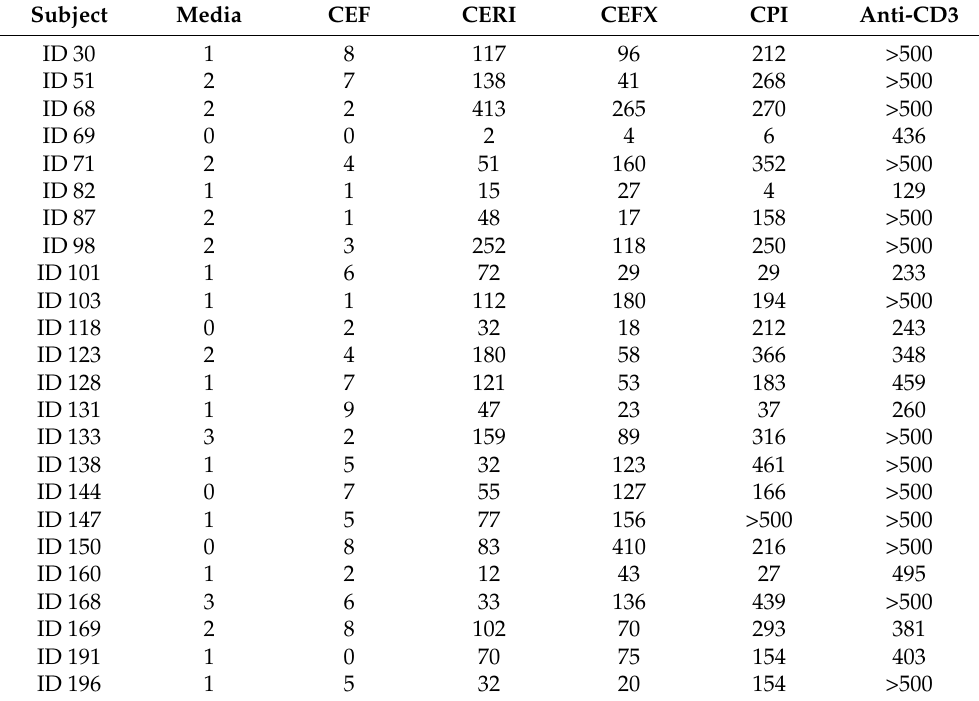
Table 1. CEF-negative PBMC can respond to other T cell stimuli. PBMC that showed no response to CEF (<10 SFU/300,000 PBMC) were tested simultaneously for CERI, CEFX, CPI and anti-CD3- induced T cell activation in a standard 24 h IFN- γ ImmunoSpot ® assay at 300,000 PBMC/well, in triplicates each. Mean SFU counts are shown for all